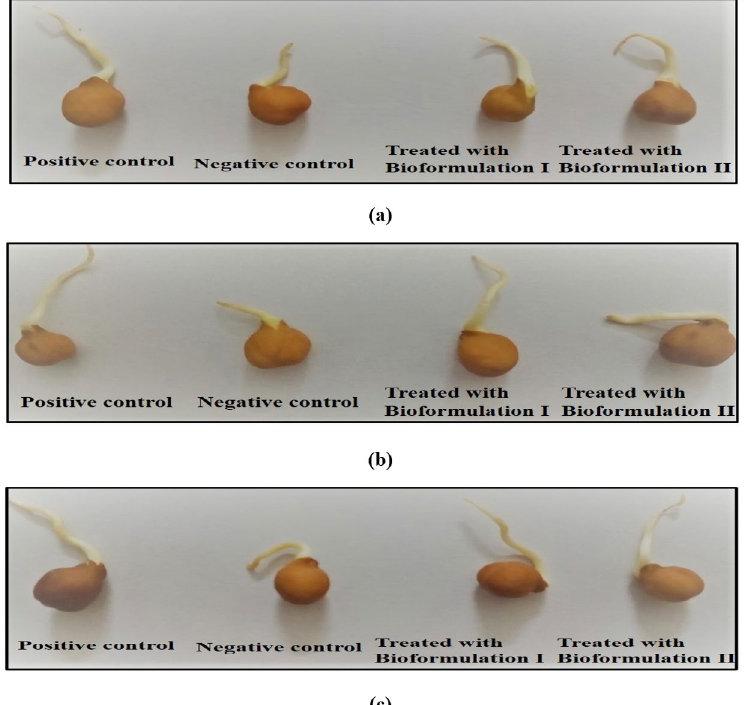
Fig. 8. Seed germination rate of Cicer arietinum in samples of a) Electroplating industry b) Battery industry c) Steel